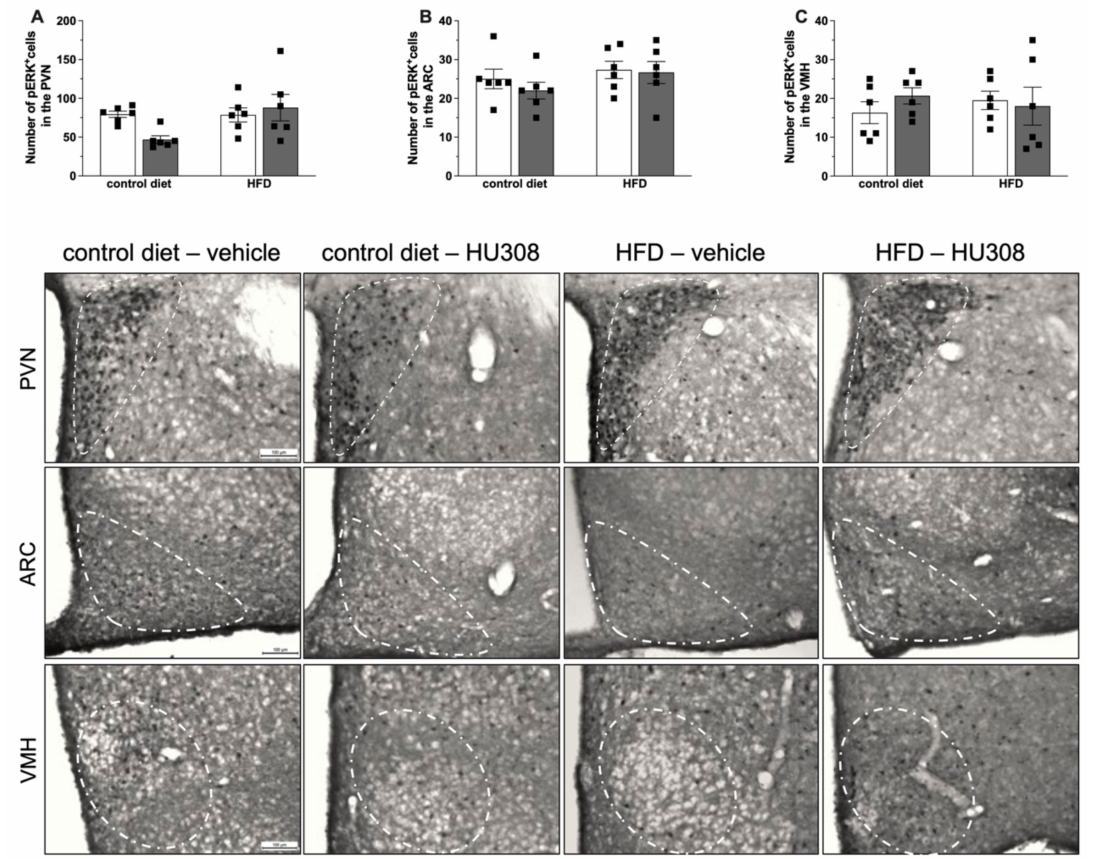
Figure 5. Effect of prolonged icv infusion of vehicle or HU308 for 2 weeks on the number of pERK+ cells in the paraventricular (PVN), arcuate (ARC) and ventromedial (VMH) nuclei in animals fed a control diet or high-fat diet (HFD). Number of pERK+ cells in the PVN ( A ), ARC ( B ) and VMH ( C ) nuclei in animals fed a control diet or HFD that received icv injection of vehicle or HU308. The data are expressed as the mean ± SEM, n = 6 per group. Data were analyzed by two-way ANOVA followed by Tukey’s post-hoc test. Bottom panel: Representative photomicrographs of pERK immunostaining in the PVN (superior panel), ARC (central panel) and VMH (inferior panel) of control diet-fed or HFD-fed animals treated with vehicle or